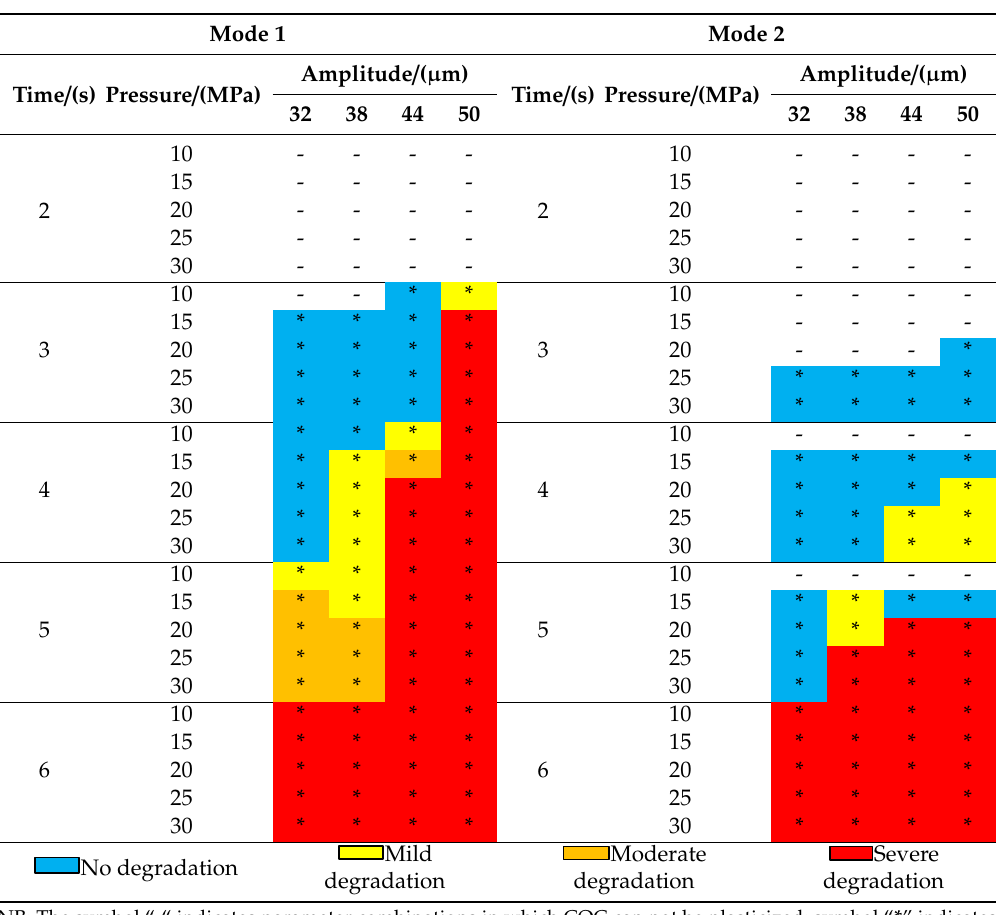
Table 5. Design of the parameter combinations of the preliminary experiment and the results under Mode 1 and Mode 2.